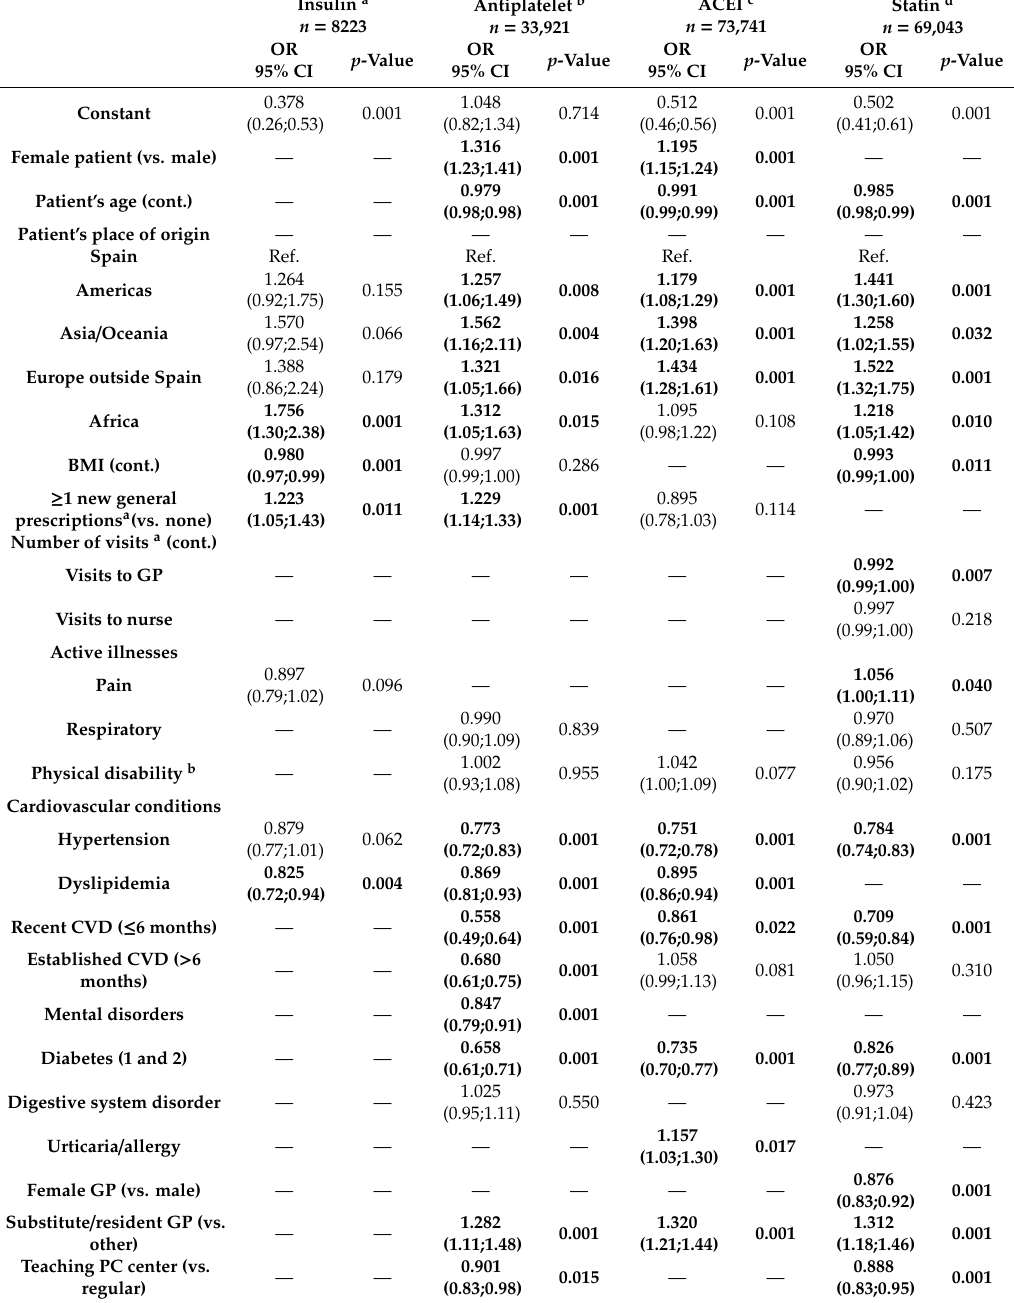
Table 4. Explanatory factors of single dispensing within a 3-months period based on multivariate multilevel